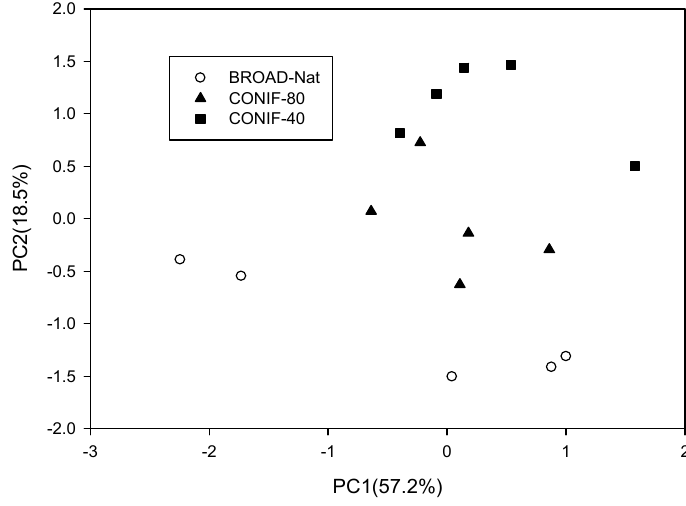
Figure 4. Plots of the two first principal components (PCs) from the principal component analysis of the mole % microbial phospholipid fatty acid content in soil samples from three forest types in winter.